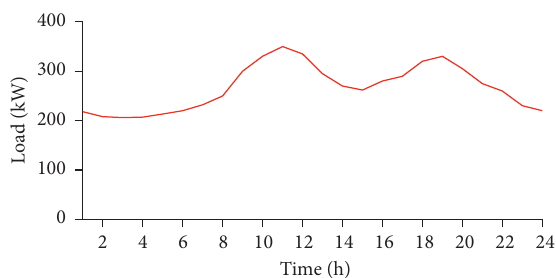
Figure 7: The hourly forecast load demand curve.